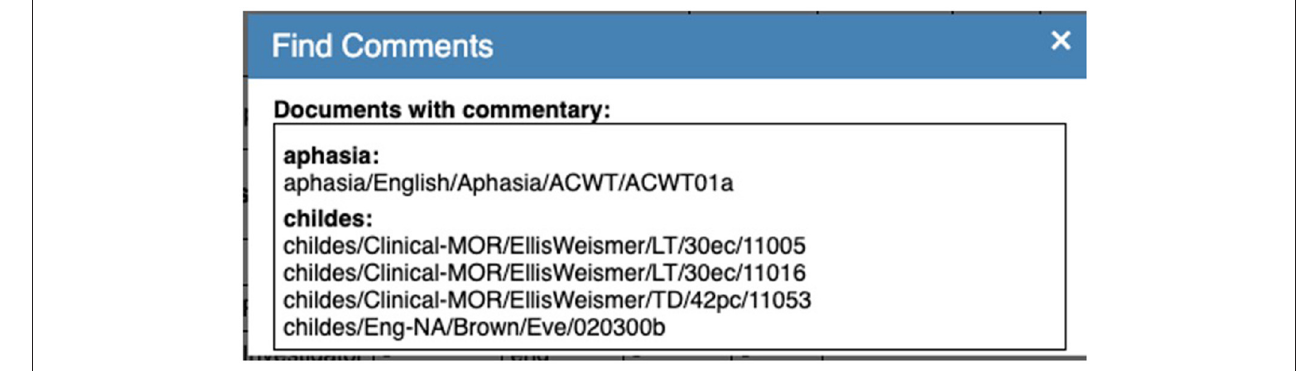
FIGURE 8 | Finding collaborative comments.